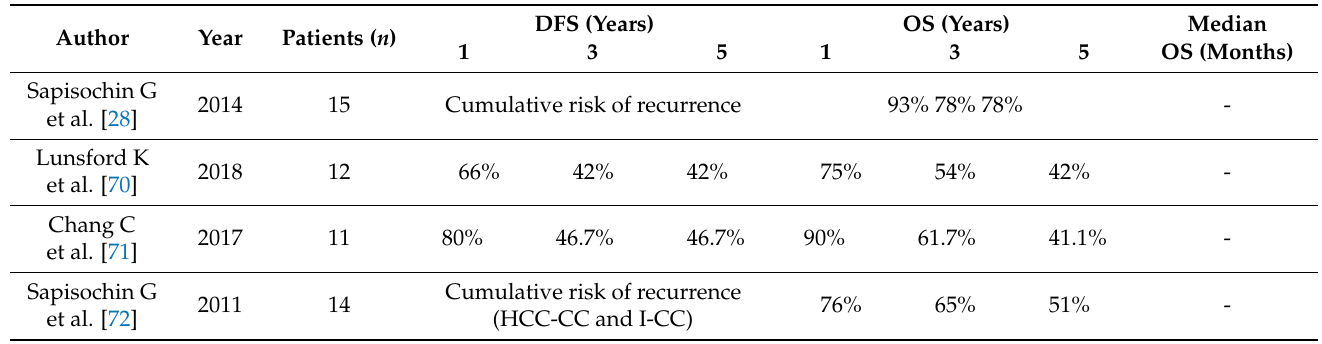
Table 2. Comparative, retrospective analysis of long-term oncological outcomes after liver transplan- tation for